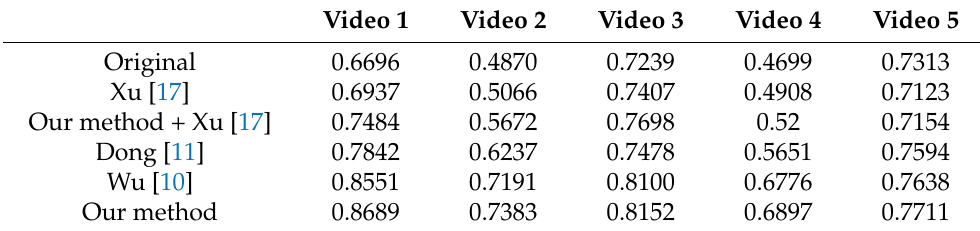
Table 3. SSIM Comparison of different methods for shaky videos with